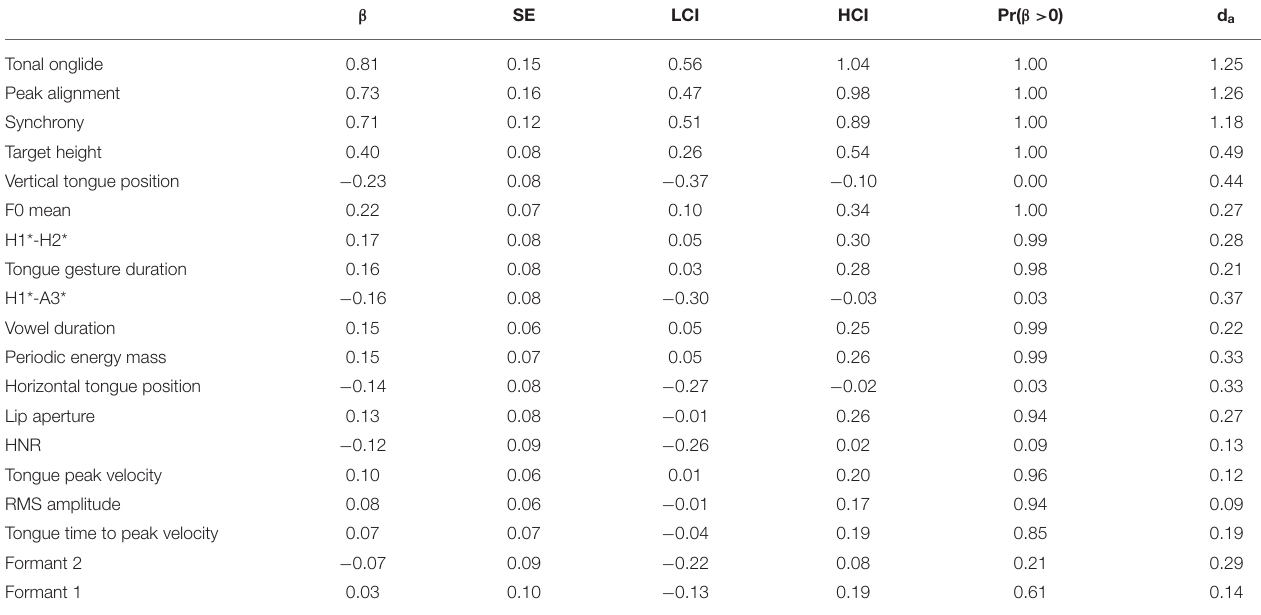
TABLE 6 | Tabular overview of modeling results for broad vs. contrastive focus, vowel /o/. LCI and HCI refer to the low and high boundaries of the 90% Credible Interval.